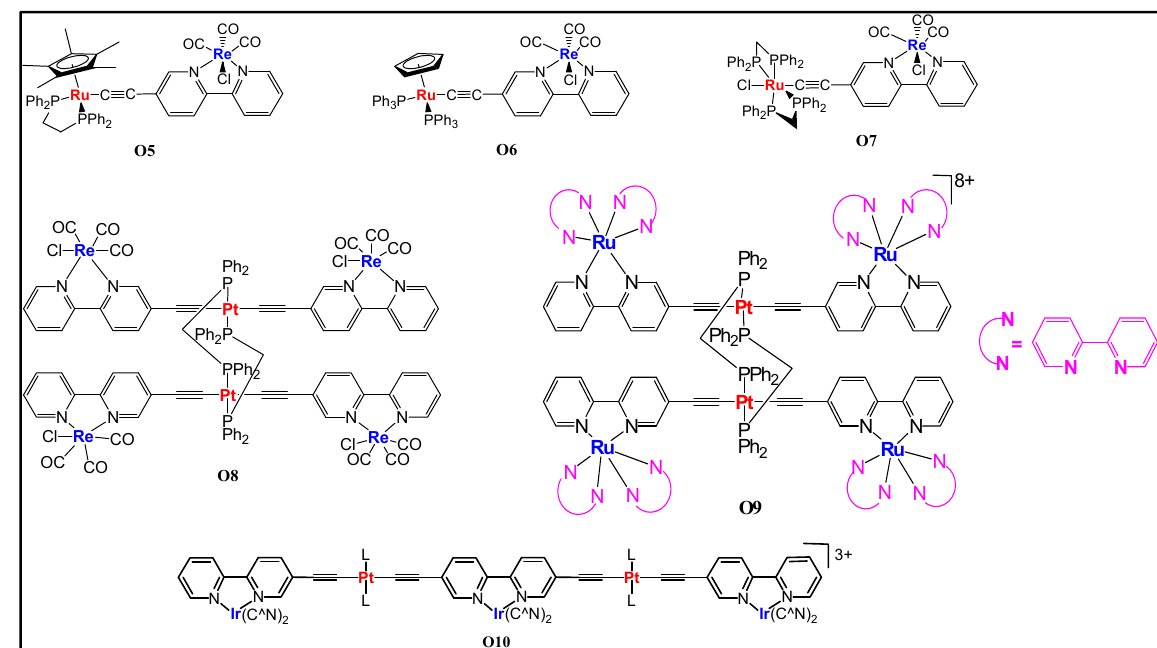
Figure 8. Structures of the d - d and d - f type heterometallic complexes O5 − O10 . In addition to these small molecular systems, several polymeric complexes bearing d - d metal fragments were also investigated [53]. Complex O10 (Figure 8) is an example of a highly emissive (Table 2) pentanuclear complex containing Pt(II) and Ir(III) fragments [54]. An efficient triplet energy transfer between the terminal and central Ir(III) cores through the Pt(II) moiety was reported in such systems. Table 2. Photoluminescence (PL) data of some selected heterometallic metalla-ynes O1 − O4 and O8 − O10 .